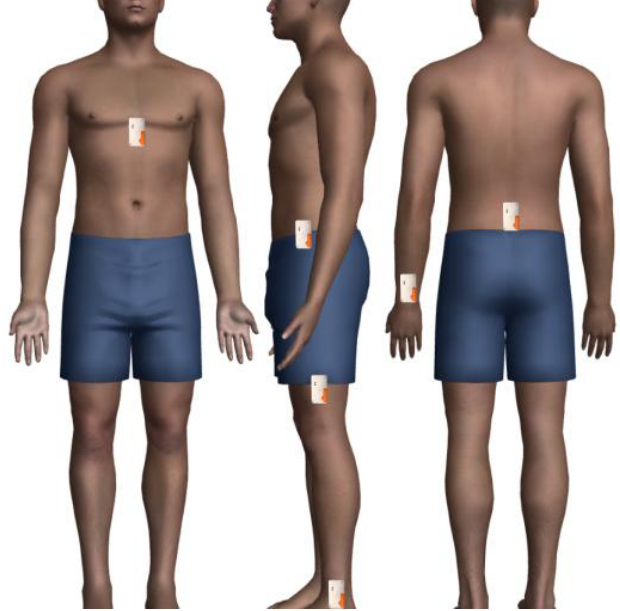
Figure 2. Selected placement locations for the accelerometers. These include the chest, lower back, hip, thigh, wrist and foot. Accelerometers were fixed on top of clothing using elasticated strapping and